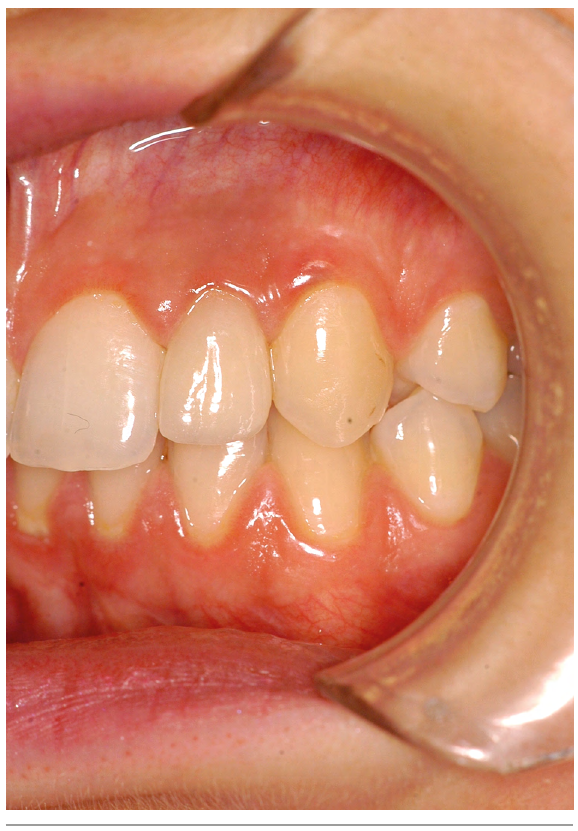
Figure 7. Clinical control at 24-month follow-up in a Group 2 patient.